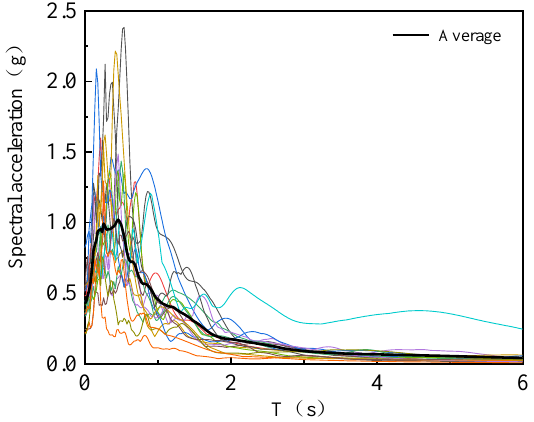
Figure 14. Acceleration response spectra (5% damping ratio).